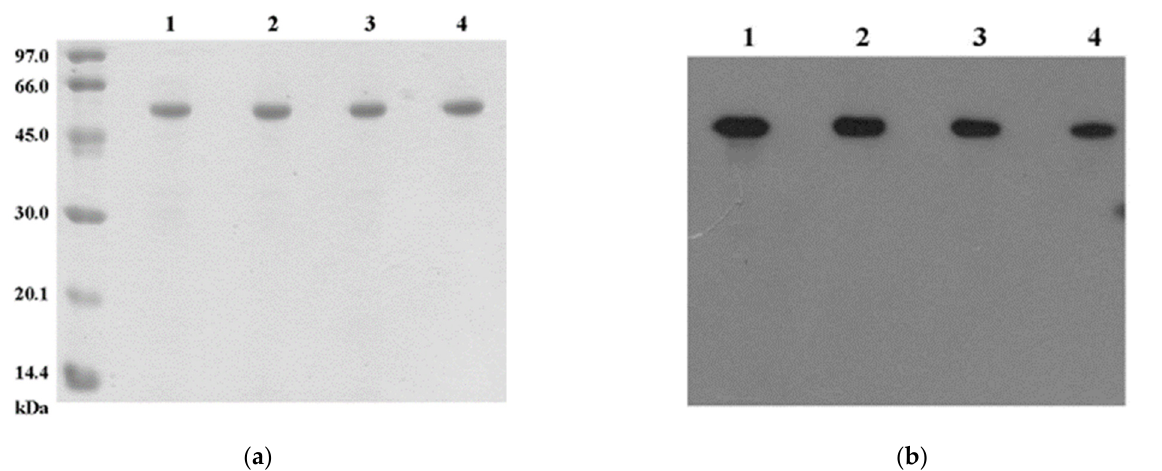
Figure 1. SDS-PAGE (12%) analysis of a crude extract. The supernatant fraction of cell lysate was incubated at 37 °C ( lane 1 ) or 25 °C ( lane 2 ). A low molecular weight protein marker was loaded and labeled their molecular weights.